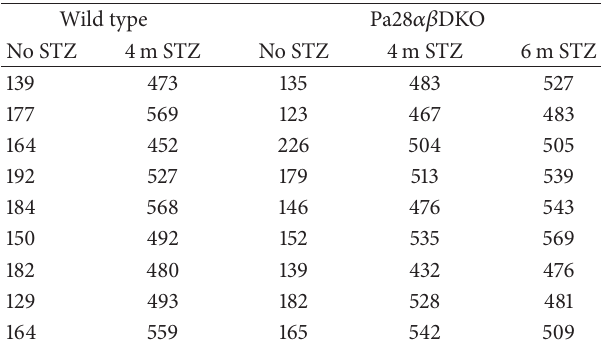
Table 1: Blood glucose levels in nondiabetic and STZ-injected diabetic